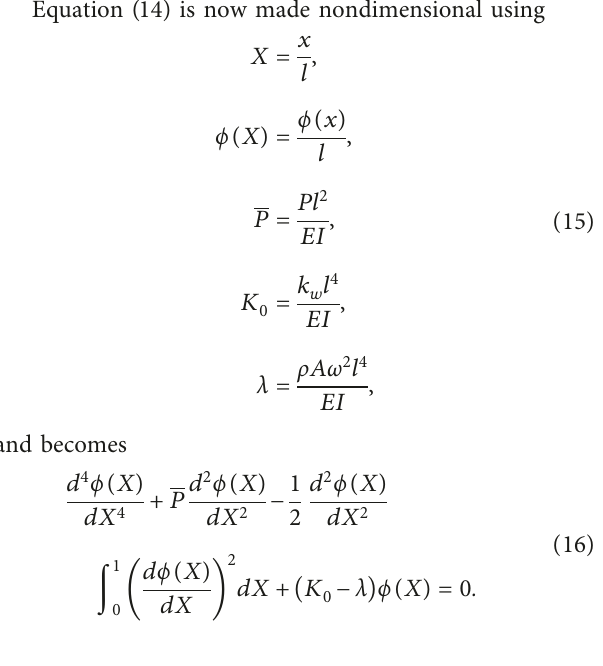
Figure 1: Beam under axial loading while resting on an elastic